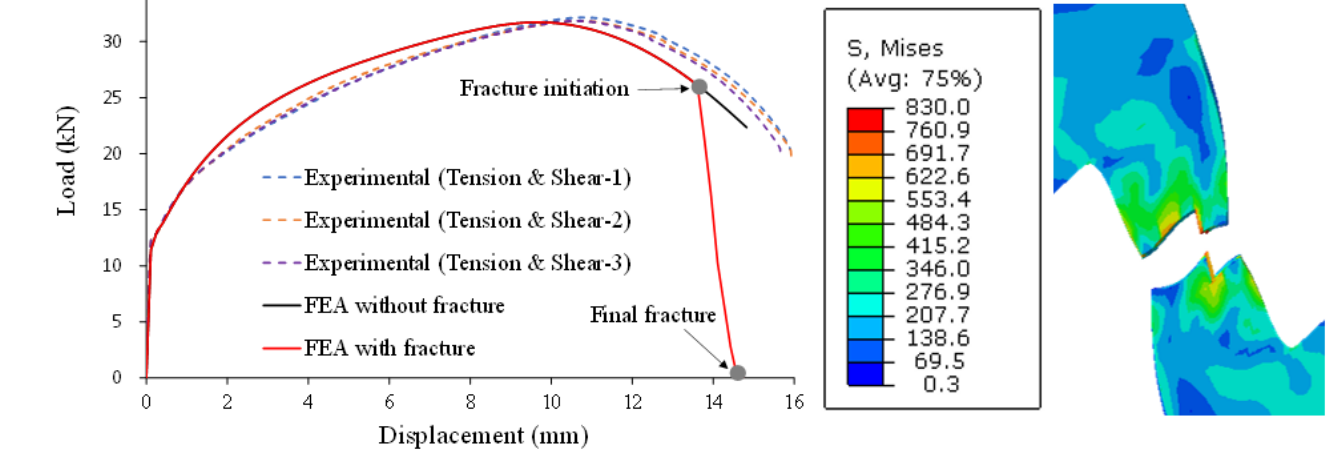
Figure 11. Results of fracture simulation on tension and shear specimens .